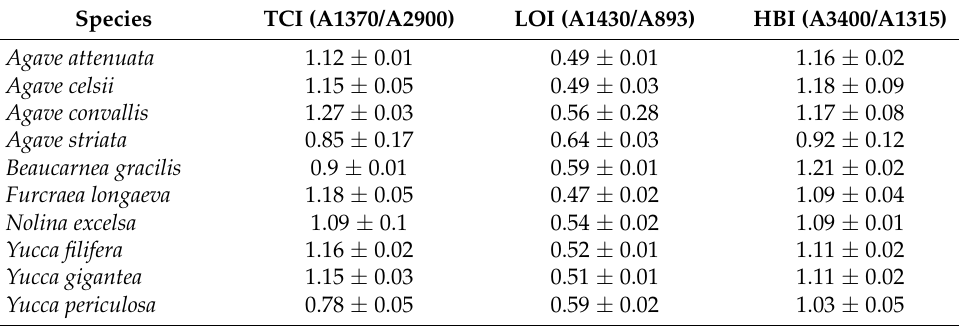
Table 7. Crystallinity indexes of Asparagaceae